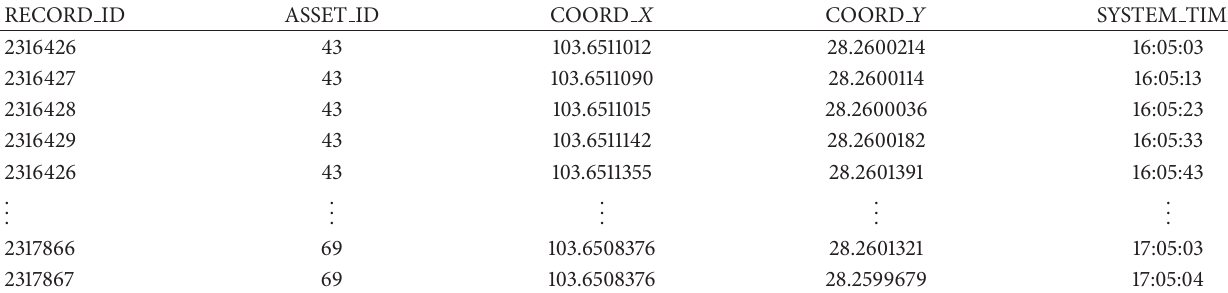
Table 3: Records of the trajectories.